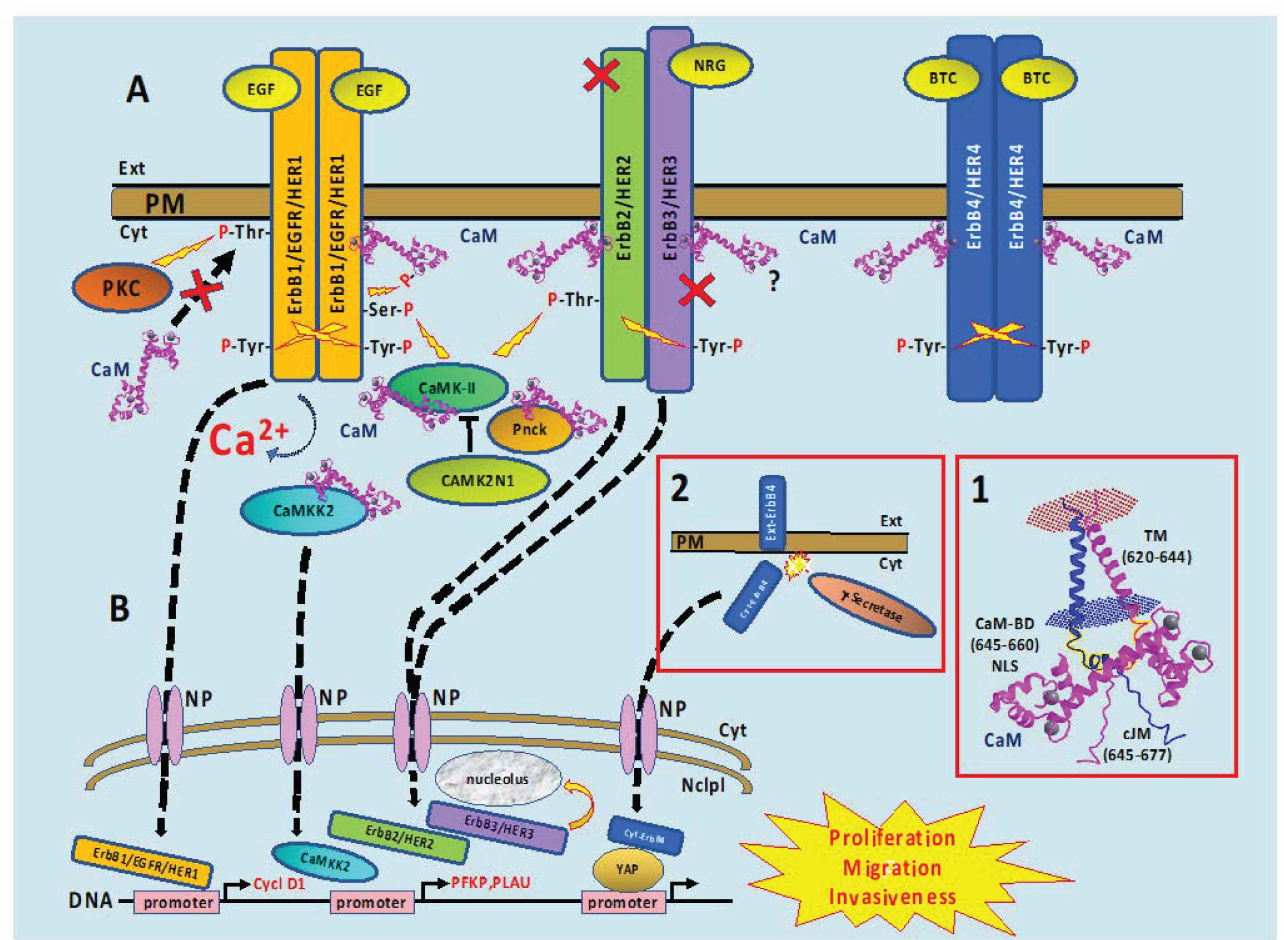
Figure 4. Direct and indirect regulation of the ErbB receptors by CaM. ( A ) The drawing shows the ErbB1/EGFR/HER1 homodimer, ErbB2/HER2:ErbB3/HER3 heterodimer and ErbB4/HER4 homodimer in the plasma membrane, activated by auto(trans)phosphorylation (yellow lightening) upon binding of the ligands: EGF, NRG and BTC, respectively. The red crosses in the ErbB2:ErbB3 heterodimer indicate the absence of ligand binding capacity of ErbB2 and absence of tyrosine kinase activity of ErbB3. The drawing in inset 1 depicts an enlarged view of Ca 2+ /CaM bound to the CaM-BD (highlighted in yellow) in the cytosolic juxtamembrane region of an EGFR homodimer. The NLS sequence coincides, in part, with the CaM-BD sequence. The numbers indicate the amino acid residues in the sequence of the mature EGFR. The region of CaM interacting with the receptor is arbitrarily selected. The structures of Ca 2+ -bound CaM (PDB ID: 1CLL) [32] and the transmembrane–cytosolic juxtamembrane segment of the EGFR (PDB ID: 2M20) [107] were taken from the National Center for Biotechnology Information (NCBI). The transient increase in the cytosolic Ca 2+ concentration generated by ligand-dependent EGFR activation [108] induces the formation of the Ca 2+ /CaM complex and activation of CaMK-II, CaMKK2 and Pnck. Ca 2+ /CaM is shown bound to the ErbB receptors and CaMK-II, CaMKK2 and Pnck. The question mark in ErbB3 indicates that Ca 2+ /CaM has a very low affinity for this receptor; therefore, its physiological function is questionable. The tumor suppressor CAMK2N1 is an inhibitor of CaMK-II, which inhibits ErbB2 downstream signaling pathways. The EGFR phosphorylates CaM at Tyr99 and Tyr138, which interacts with the receptor at the same site as non-phosphorylated CaM; more details about this process are shown in Figure 1. The phosphorylation of Thr654 by PKC prevents Ca 2+ /CaM binding to the EGFR (red cross). CaMK-II phosphorylates serine and threonine